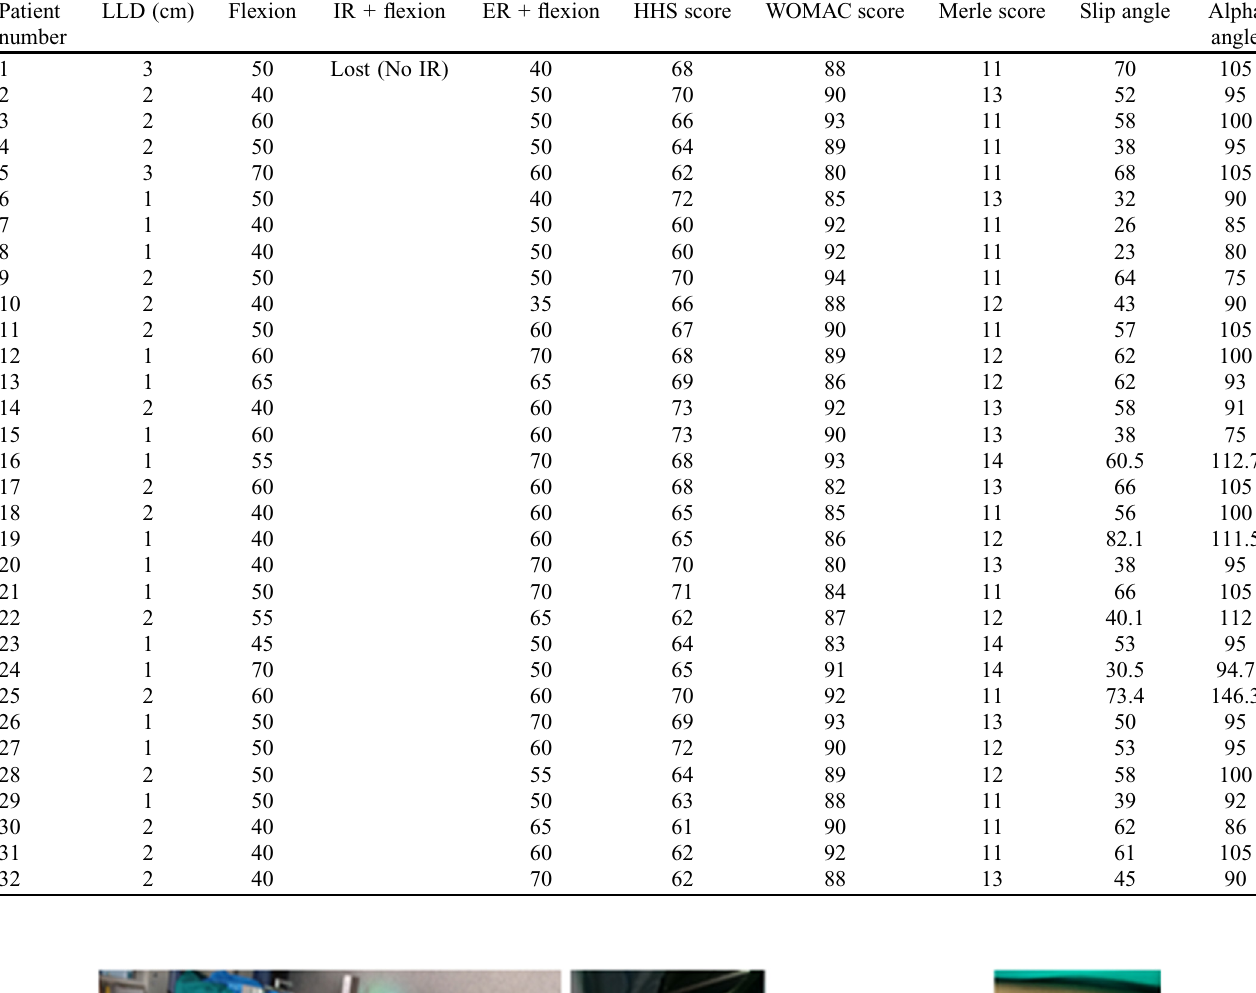
Table 2. Preoperative features of slipped capital femoral epiphyses (SCFE) patients.